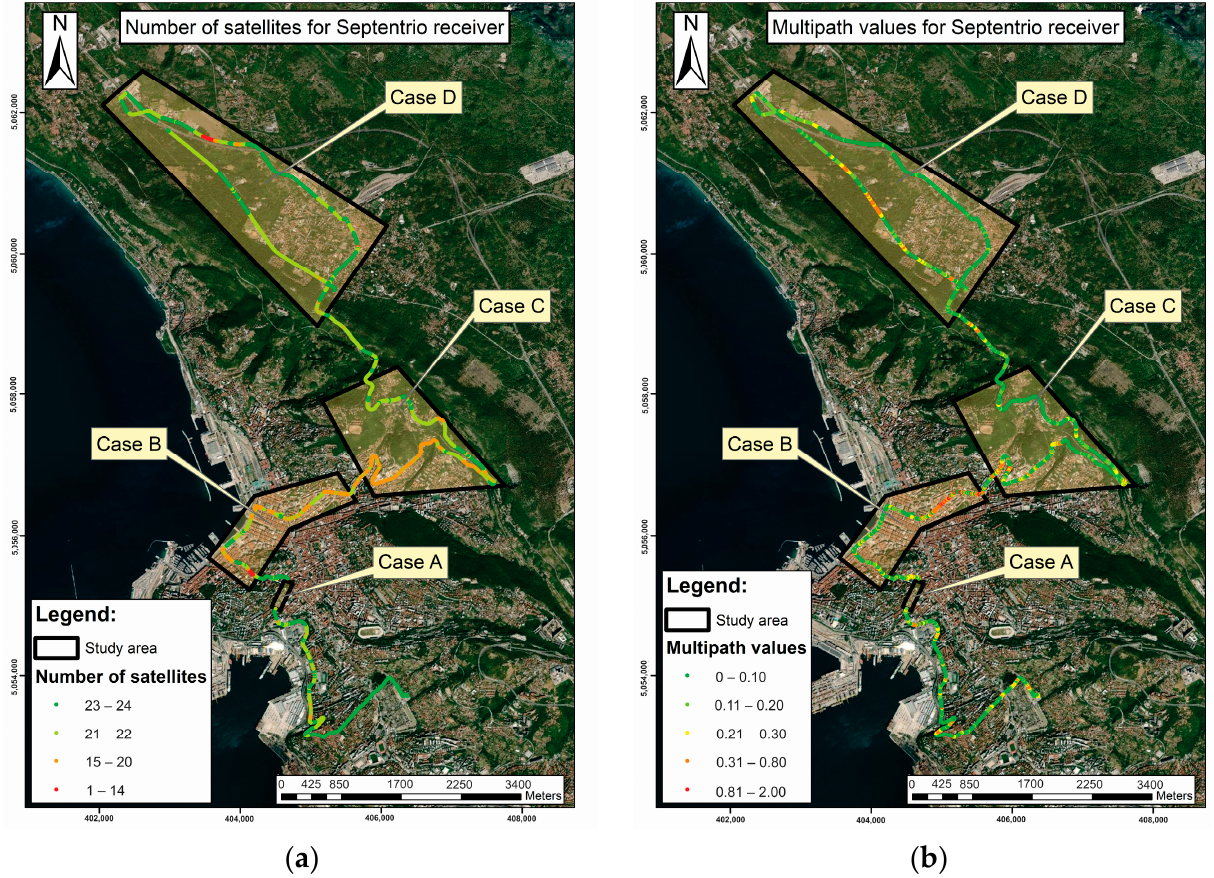
Figure 6. ( a ) Number of available satellites along the route, and ( b ) multipath in metres for the Sep tentrio AsteRx-U receiver.